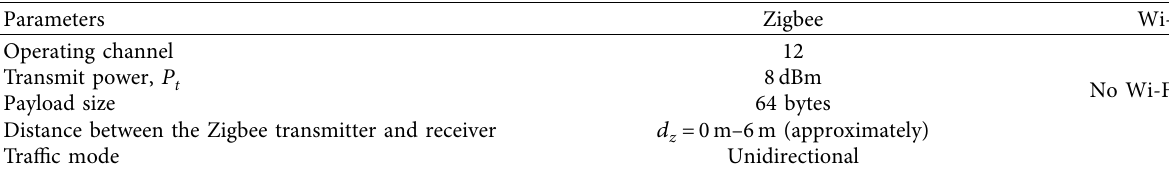
Table 5: Parameters for the experiments in Section 4.2.2 (1).